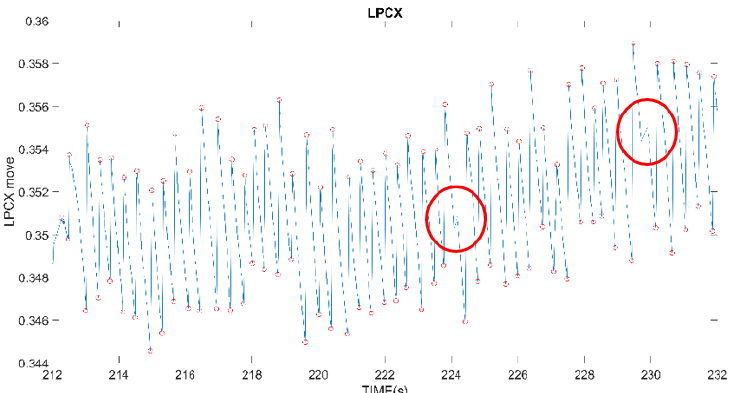
Figure 5. The gap (red-circled) between two adjacent extreme values is too small to be processed. The OKN test in this experiment is a dynamic fringe film that shifts left and right at various speeds. In Figure 5, the movement trajectory of the subject’s eye gaze position in the OKN test can be observed with a left and right displacement. The OKN phenomenon connected by the extreme values has a positive slope when the stimulus movement direction is moving to the left. (The SP phenomenon is a positive slope, which means that the subject’s eye movement direction is to follow the stimulation direction to the left in the video. The negative slope here is the FP phenomenon, which means that the subject’s eyeball resets the saccade movement) Conversely, when the direction of the stimulus is moving to the right, it exhibits a negative slope.